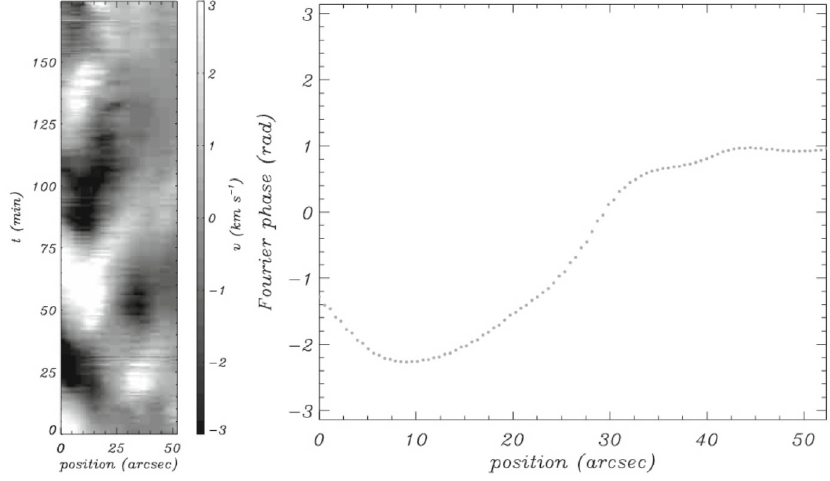
Fig. 25 Doppler velocity versus position and time along the dashed path in Fig. 23. Left: Raw Doppler signal. Right: Fourier phase associated to the 75 min periodicity. Image reproduced with permission from Terradas et al. (2002), copyright by ESO